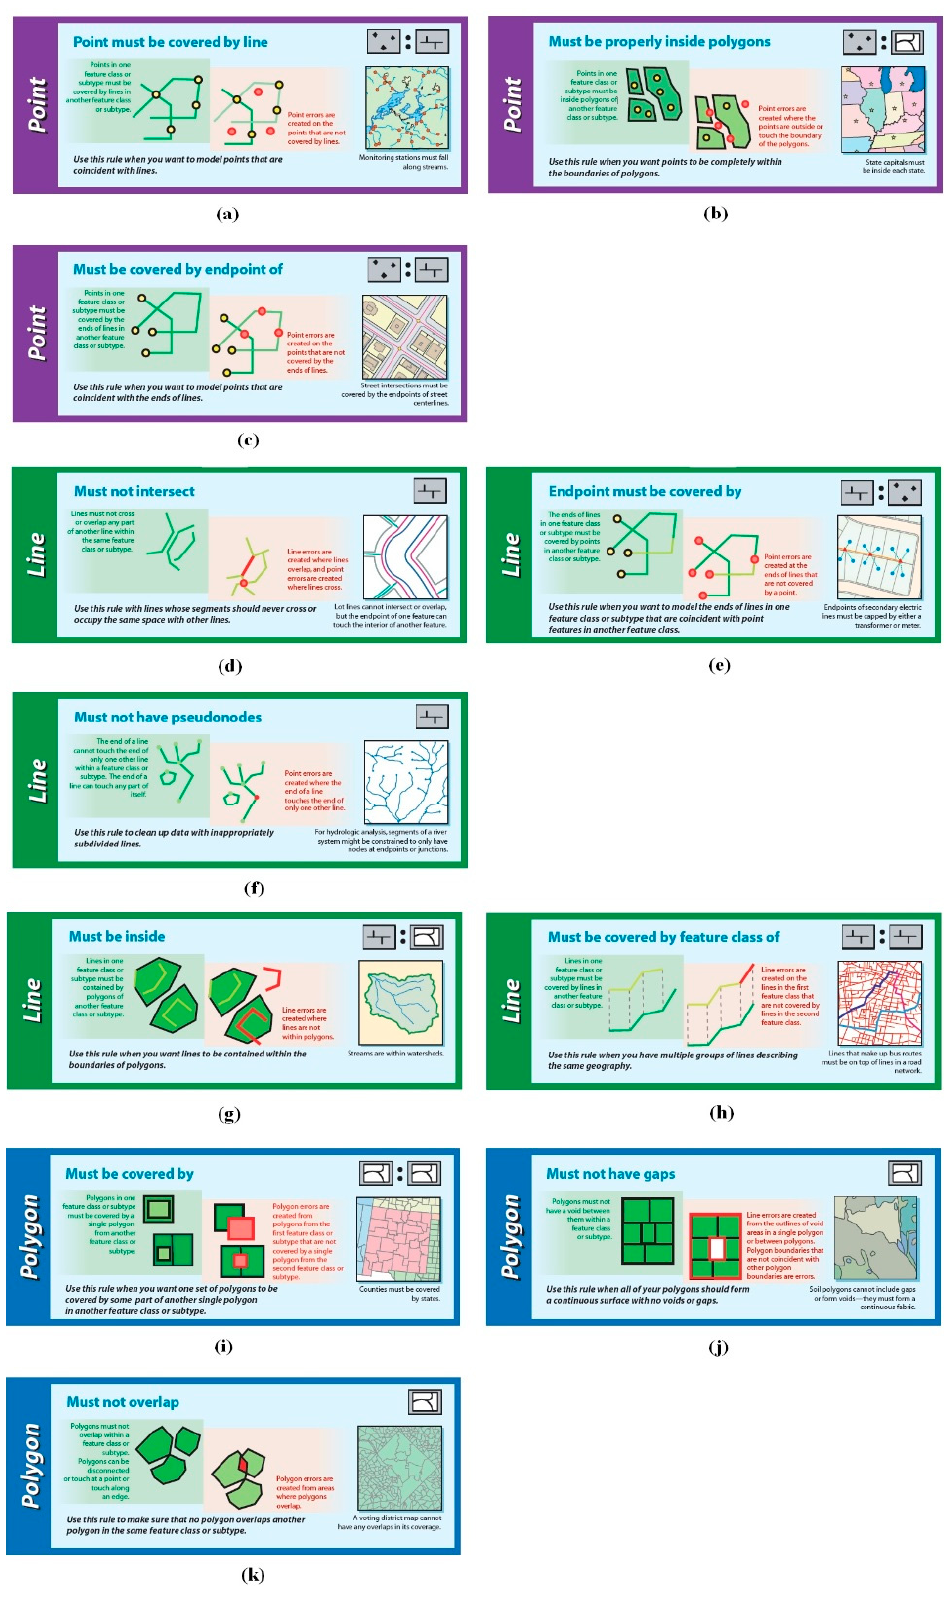
Figure 14. Details of the topological rules used.